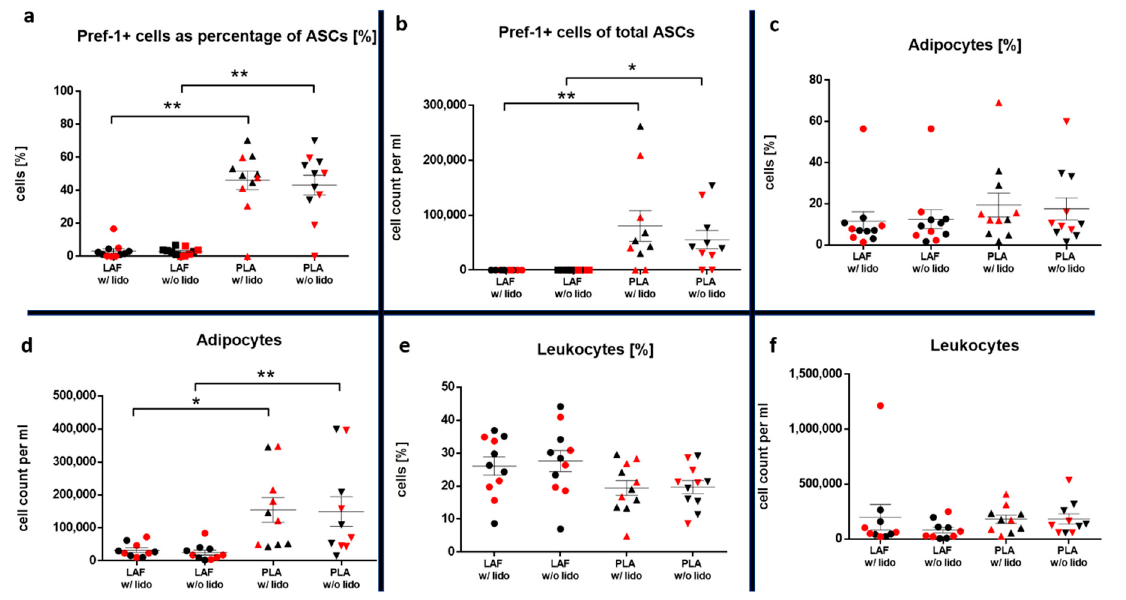
Figure 6. In these graphs, the relative distribution ( n = 11) and absolute number ( n = 10) of stem cells expressing the preadipocyte marker Pref-1 ( a , b ), as well as mature adipocytes ( c , d ) and leukocytes ( e , f ) inside the SVF of the fluid (LAF) and fatty (PLA) portion w / an w / o lidocaine were compared. Samples of each patient are marked in every group. The mean and standard error of the mean in each group is shown. For multiple comparisons, the Kruskal–Wallis test was used. The α -value was at 0.05. Patients with a BMI ≥ 30 are shown in